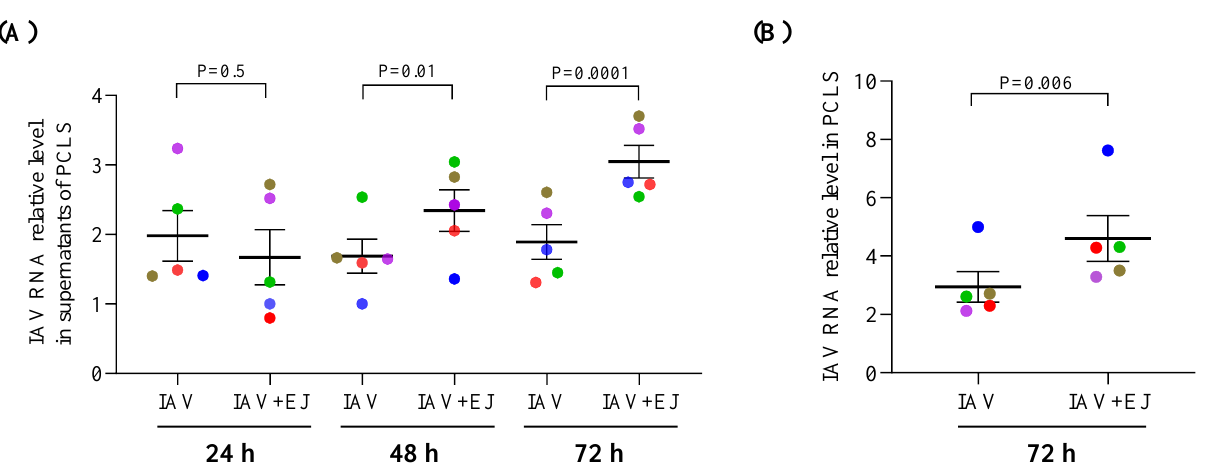
Figure 1. E-juice treatment increased influenza A virus (IAV) levels in human precision-cut lung slices (PCLS). PCLS were treated with IAV and E-juice (EJ) for 24, 48, and 72 h. IAV load in supernatants ( A ) and tissue samples ( B ) was analyzed by RT-PCR. Each data point (colored dot) represents the average of 3 replicates from each respective individual donor ( n = 5 donors). Horizontal lines indicate mean ± SEM. Paired t -test was used to analyze the data.